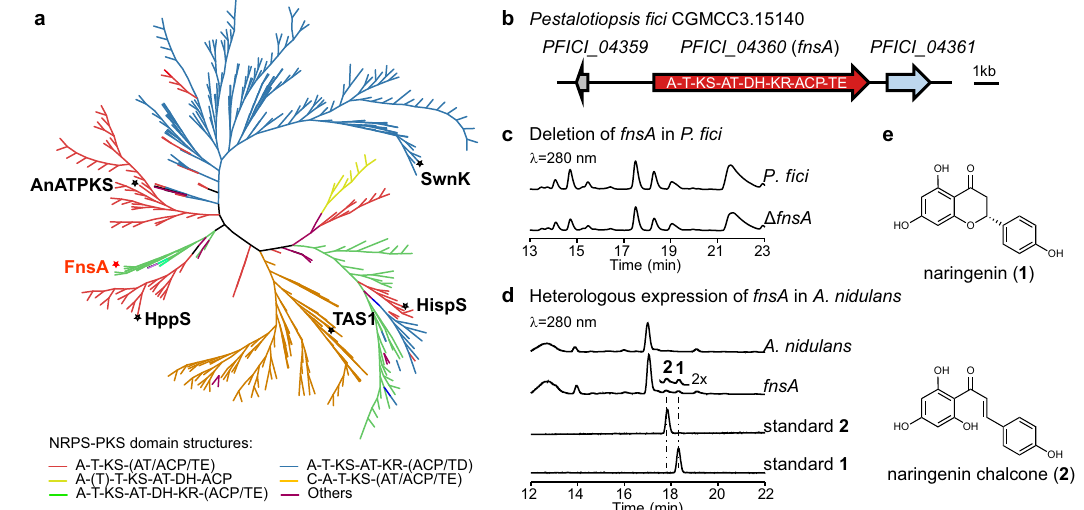
Fig. 1 |Identi fi cation ofafungalNRPS-PKShybridenzymeFnsA(PFICI_04360). a Phylogeneticanalysisof NRPS-PKS hybridenzymesfrom fungi.FungalNRPS-PKS hybrid enzymes with various domain structures are widely spread in the fungal kingdom.TAS1 18 ,SwnK 19 ,HispS 20 ,AnATPKS 21 ,andHppS 22 weretheidenti fi edfungal NRPS-PKShybridenzymes.Thetypesofdomainstructureswereshownindifferent colours. Domains in parenthesis are fl exible. A adenylation, T thiolation, KS keto- synthase, AT acyltransferase, DH dehydratase, KR ketoacyl reductase, ACP acyl